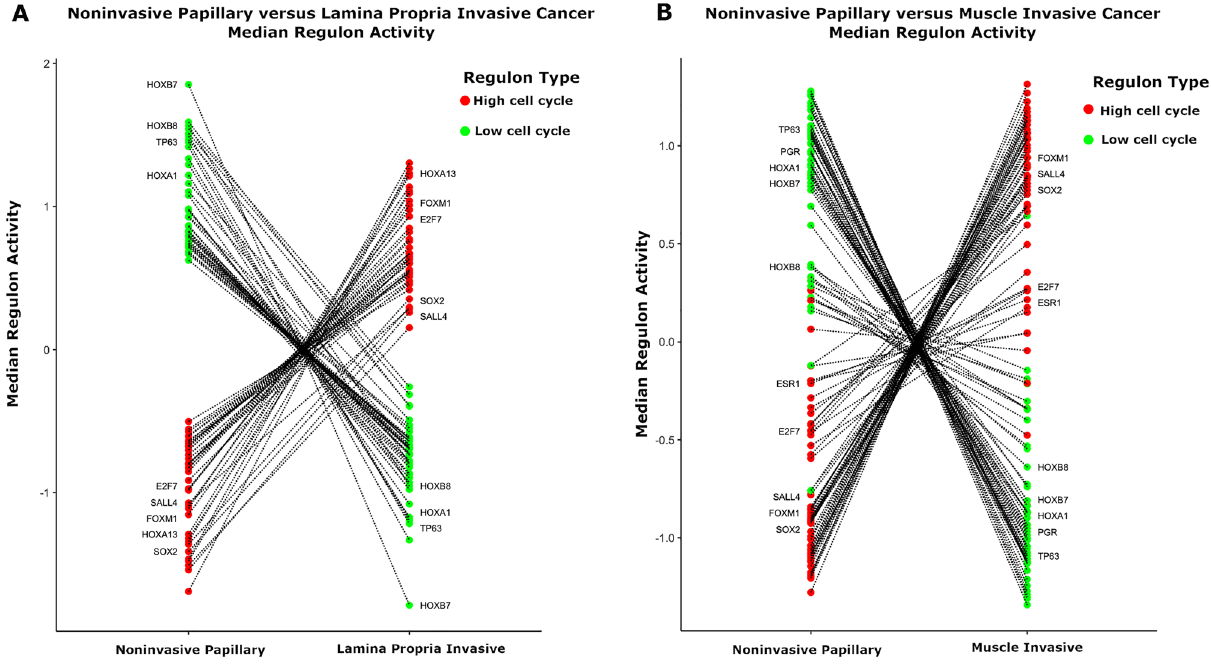
Figure 6. TF regulon activity in noninvasive papillary urothelial carcinoma (NIPUC) versus invasive urothelial carcinoma. ( A ) All 121 TF regulons differed in activity between NIPUC and invasive urothelial carcinoma limited to the lamina propria, all in the expected direction, using the Leeds Cohort (Bonferroni adjusted p < 0.05). ( B ) Similarly, 92% (111 of 121) of TF regulons differed in activity between NIPUC and invasive urothelial carcinoma extending into the muscularis propria, and 93% of these (103 of 111) did so in the expected direction, comparing NIPUC in the UROMOL Cohort to invasive cancers in the TCGA cohort. Both dot plots show regulon activity in NIPUC and invasive cancer, which are in separate columns. Each dot is the median regulon activity for a specific TF. Lines connect the same TF regulon in the NIPUC and invasive groups. Only select TF regulons are labelled, for clarity, and complete results are shown in Table